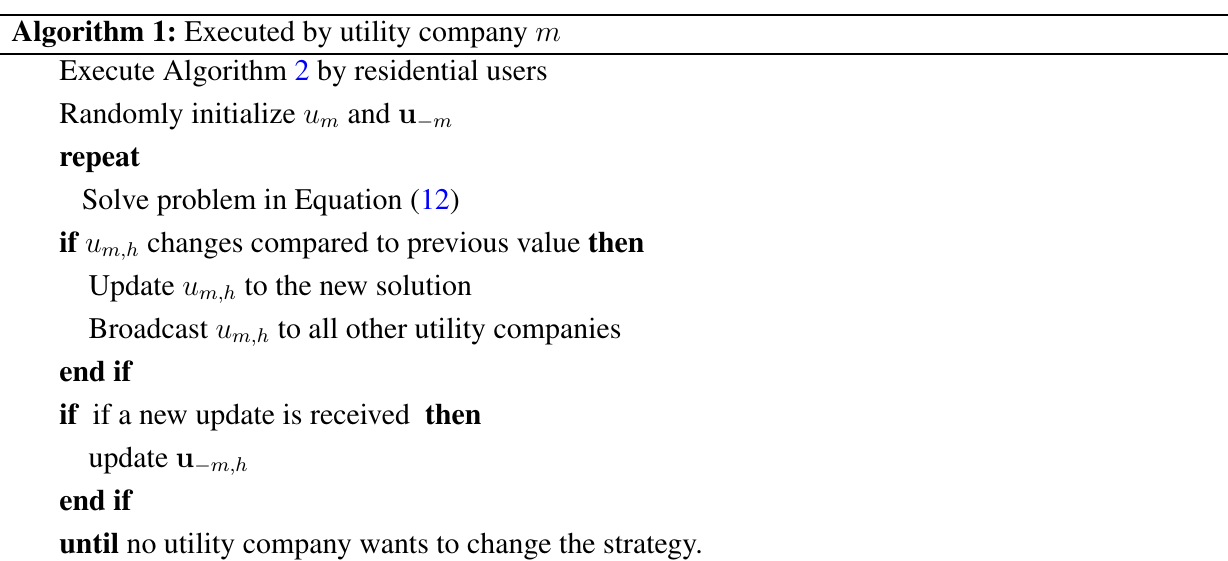
Algorithm 1: Executed by utility company